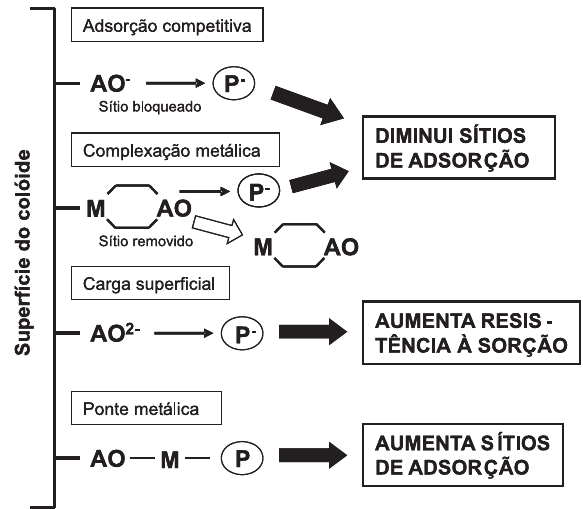
Figura 1. Competição entre ácidos orgânicos e fósforo pelos sítios de adsorção no solo (Guppy et al.,